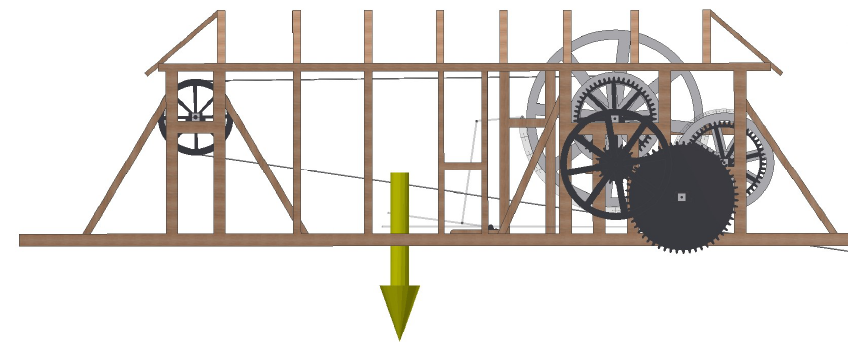
Figure 9. Gravitational force applied at the center of gravity of the engine.